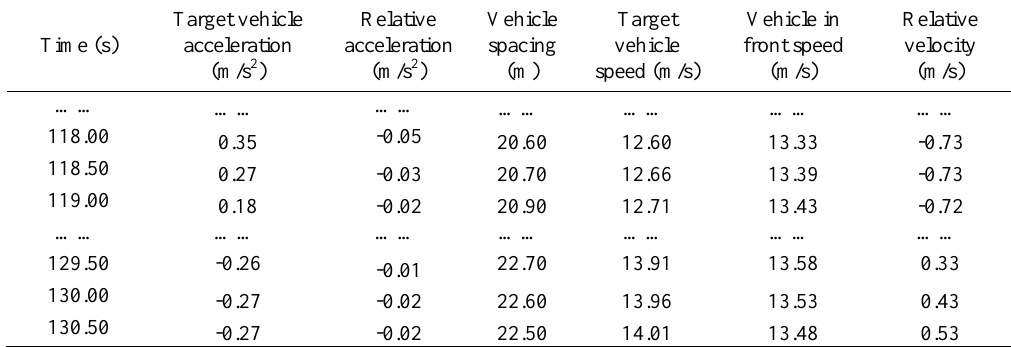
Table 7. Cautious type driver part of the experimental data